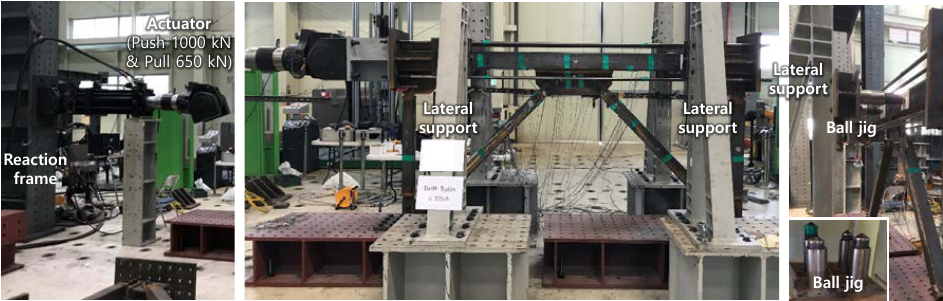
Figure 5. Test setup for cyclic lateral loading of RHS truss specimens.